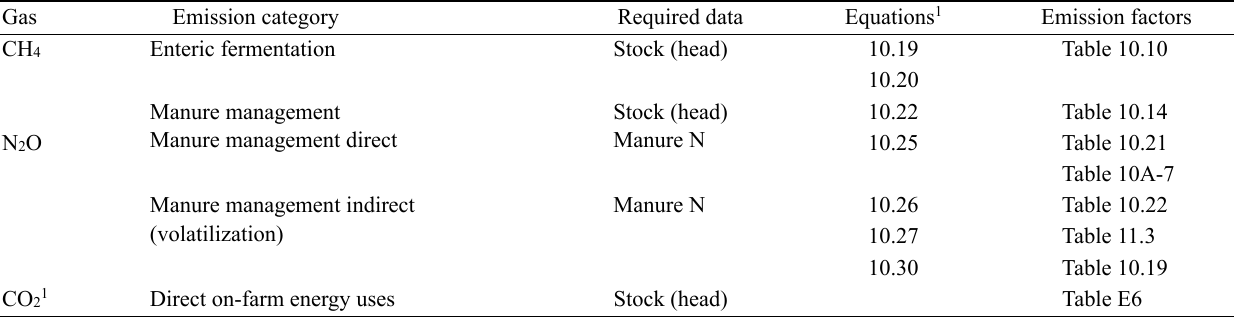
Table 1. The methods for estimation of greenhouse gases emissions, emission categories, equations, and emission